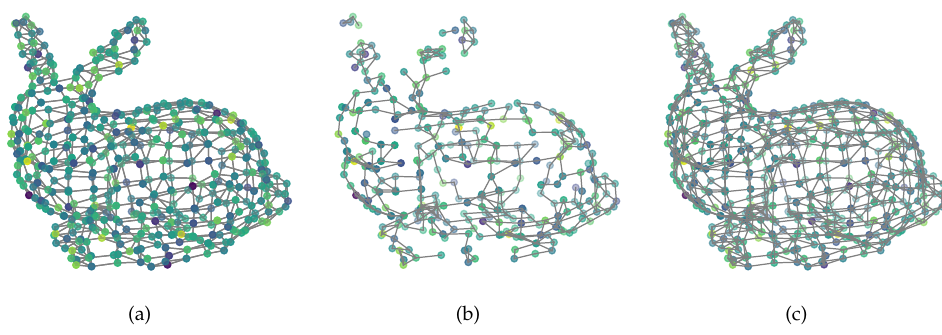
Figure 7. ( a ) Original noisy signal; ( b ) sampled noisy signal; ( c ) reconstructed